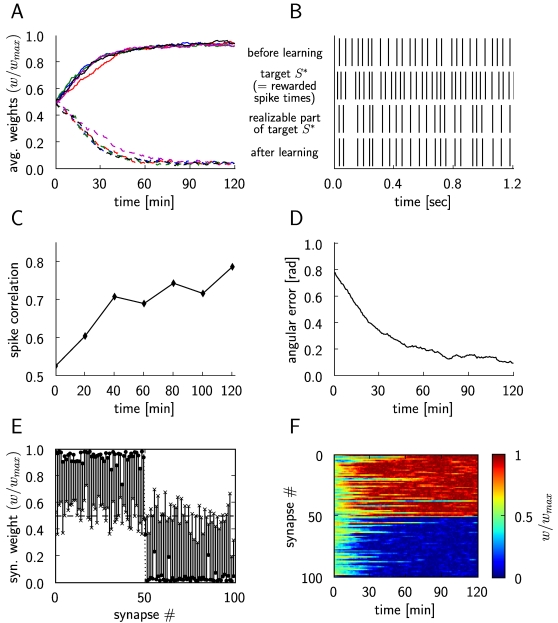
Results for reinforcement learning of exact spike times through
reward-modulated STDP.(A) Synaptic weight changes of the trained LIF neuron, for 5 different
runs of the experiment. The curves show the average of the synaptic
weights that should converge to  (dashed lines), and the average of the synaptic
weights that should converge to  (solid lines) with different colors for each
simulation run. (B) Comparison of the output of the trained neuron
before (top trace) and after learning (bottom trace). The same input
spike trains and the same noise inputs were used before and after
training for 2 hours. The second trace from above shows those spike
times S* which are rewarded, the third trace
shows the realizable part of S* (i.e. those
spikes which the trained neuron could potentially learn to reproduce,
since the neuron μ* produces them
without its 10 extra spike inputs). The close match between the third
and fourth trace shows that the trained neuron performs very well. (C)
Evolution of the spike correlation between the spike train of the
trained neuron and the realizable part of the target spike train
S*. (D) The angle between the weight vector
w of the trained neuron and the weight vector w* of the neuron
μ* during the simulation, in
radians. (E) Synaptic weights at the beginning of the simulation are
marked with ×, and at the end of the simulation with
•, for each plastic synapse of the trained neuron. (F)
Evolution of the synaptic weights
w/wmax during the
simulation (we had chosen  for i<50,  for i≥50).